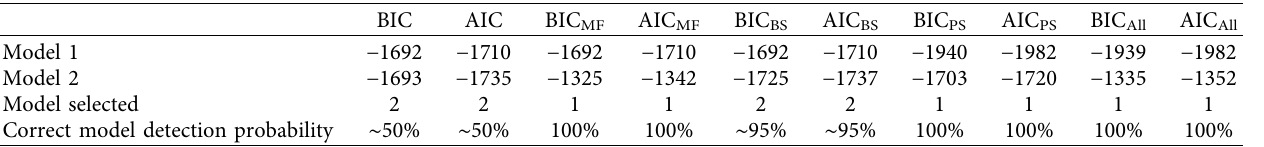
Figure 2: Generated data (from equation (15)) and fitted models (equations (16) and (17)). The sum of sines model clearly shows out-of- sample instability. Table 4: Estimates of the various versions of the indicators for the regressor example of equations